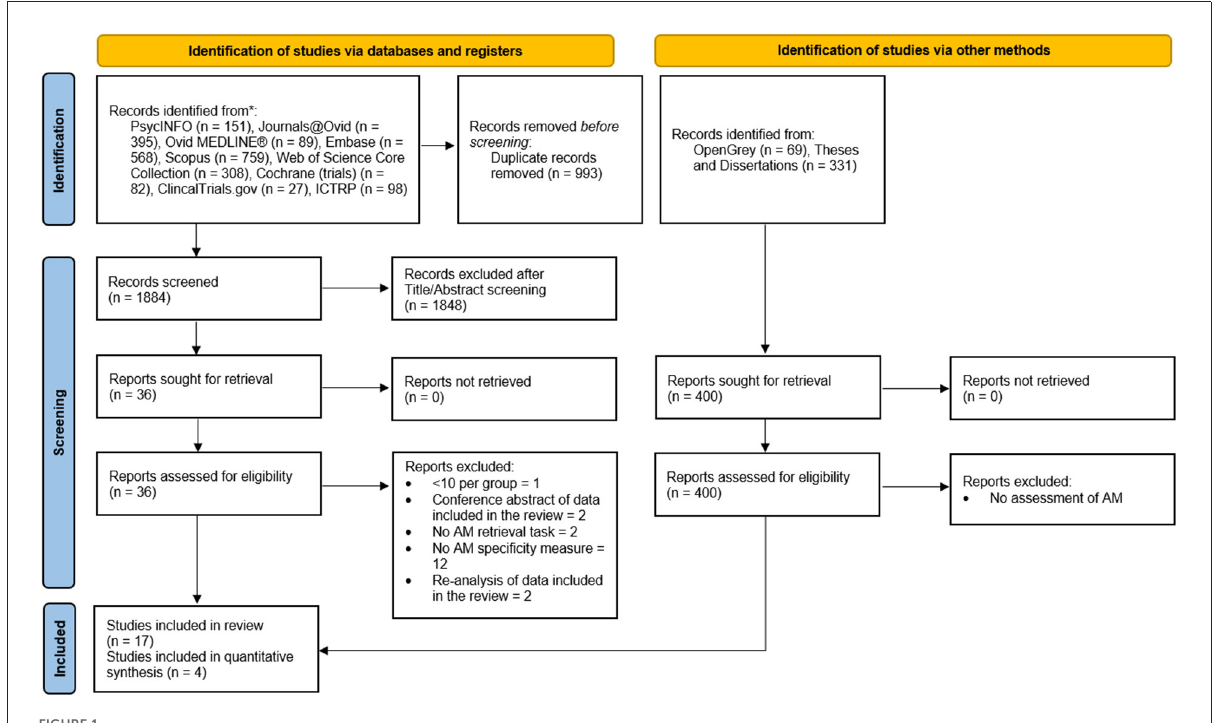
FIGURE1 Page et al. (2021) flowchart of the study selection